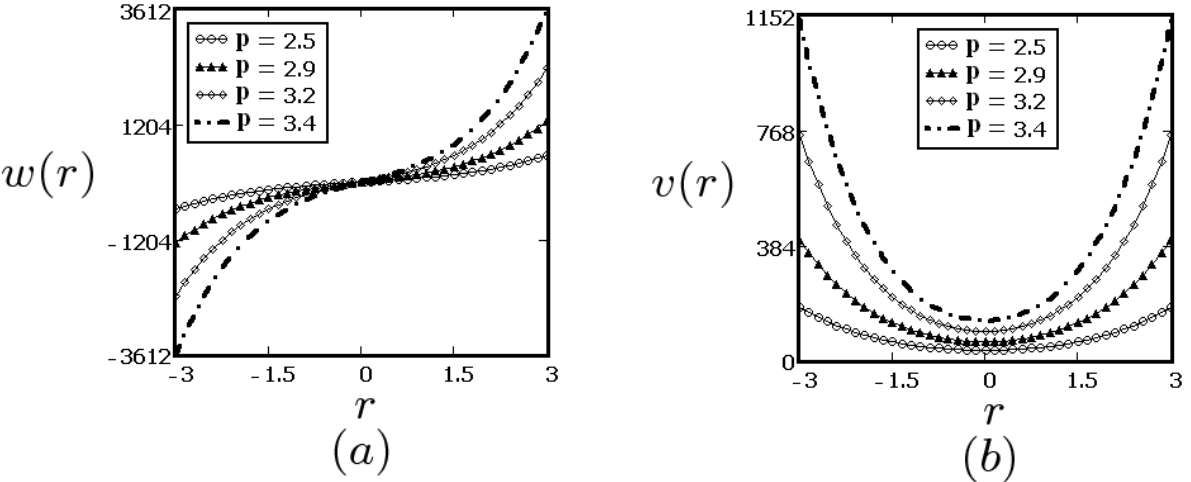
Fig. 4: Profiles of the velocity components w ( r , t ) and v ( r , t ) given by Eqs. (32) and (33), for R = 3, Ω = 1, U = 1, ν = 0.9292, µ = 26, λ = 3, α = 0.5, t = 8 s and different values of p .